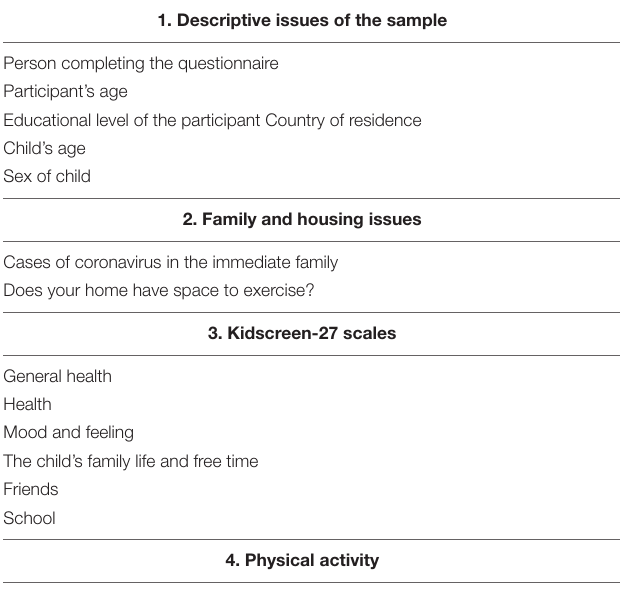
TABLE 3 | Questions included in the used